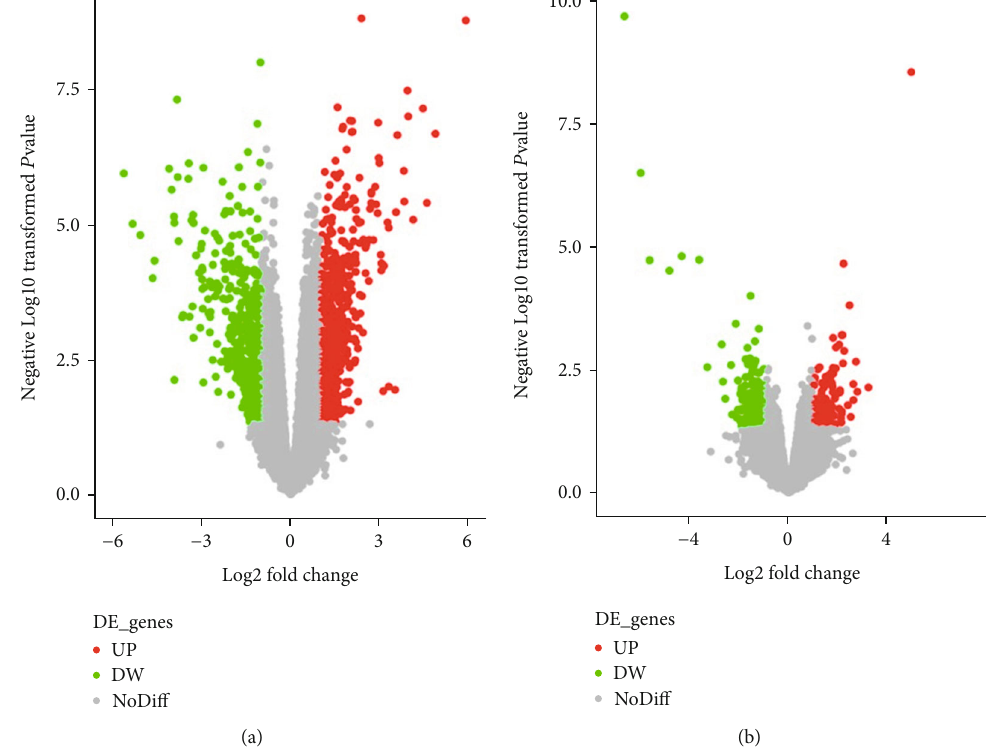
Figure 1: DEG active volcano, screening criteria: P < 0 : 05 and ∣ logFC ∣ >1 . Red dots represent upregulated genes, and the green dots represent downregulated genes. (a) RA and No-RA groups. (b) M-RA and F-RA